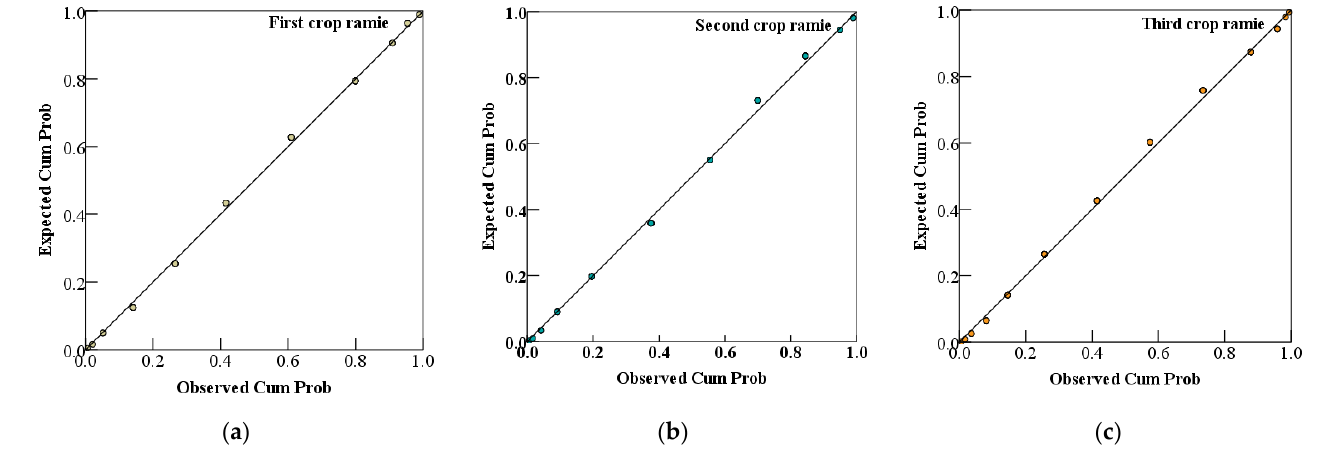
Figure 5. Normal P – P Plot of three crops of ramie. ( a ) First crop ramie; ( b ) Second crop ramie; ( c ) Third crop ramie.